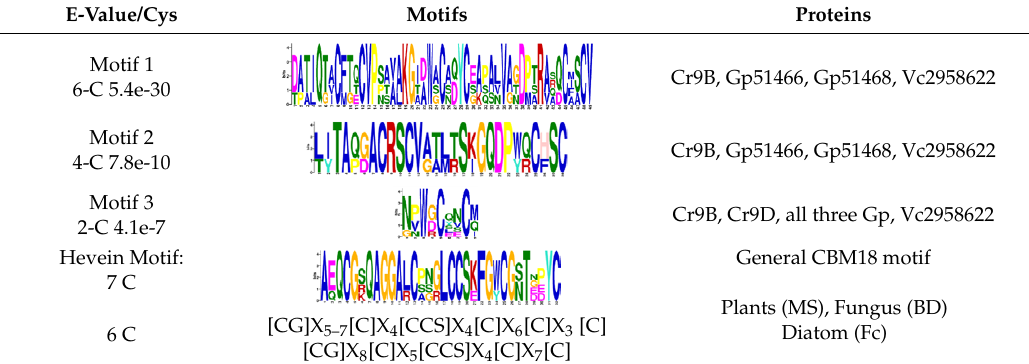
Table 1. Motif analysis of GH9-appended microalgal CBMs (carbohydrate binding modules) by MEME. E-Value/Cys Motifs